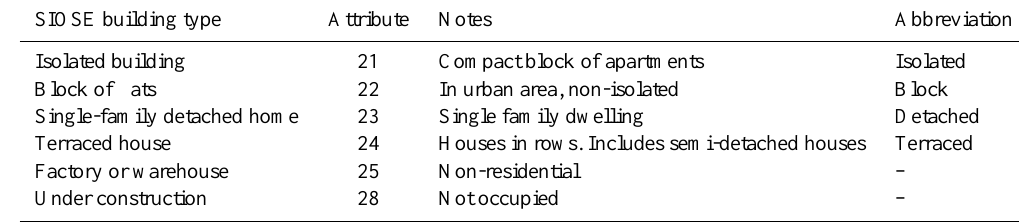
Table 2. Attributes of the SIOSE simple cover “Buildings”.